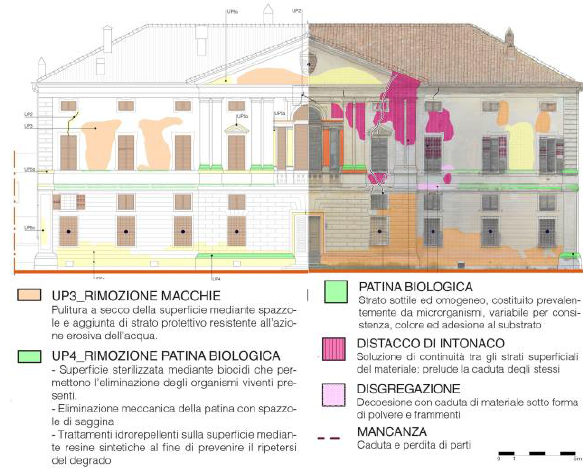
Figure 14. Decay analysis of a Palazzo Sarmatoris part generated in the HBIM